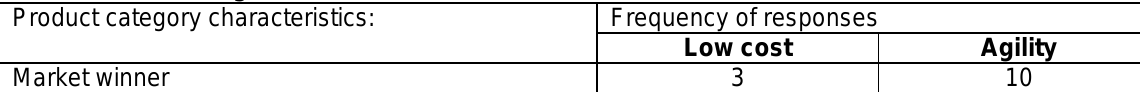
Table 3: Organisations' market winners ( n = 13) Product category